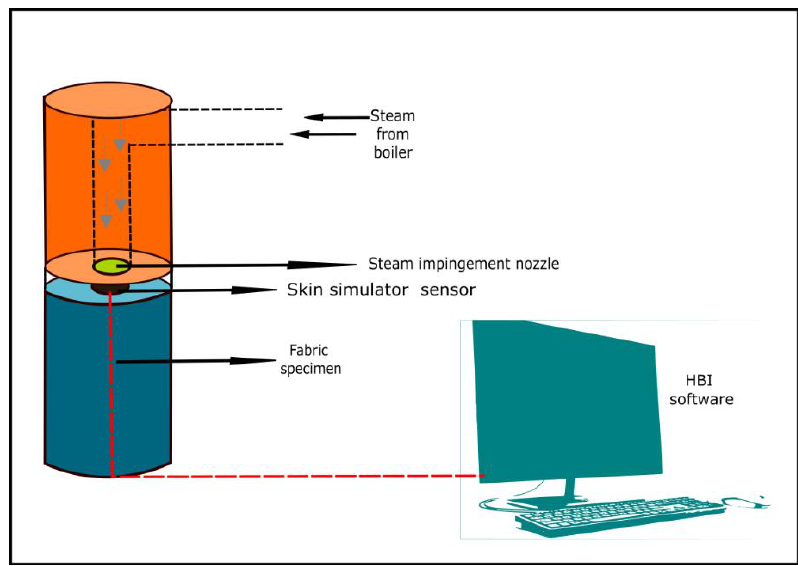
Figure 4. Thermal protective performance evaluating tester under steam exposure.